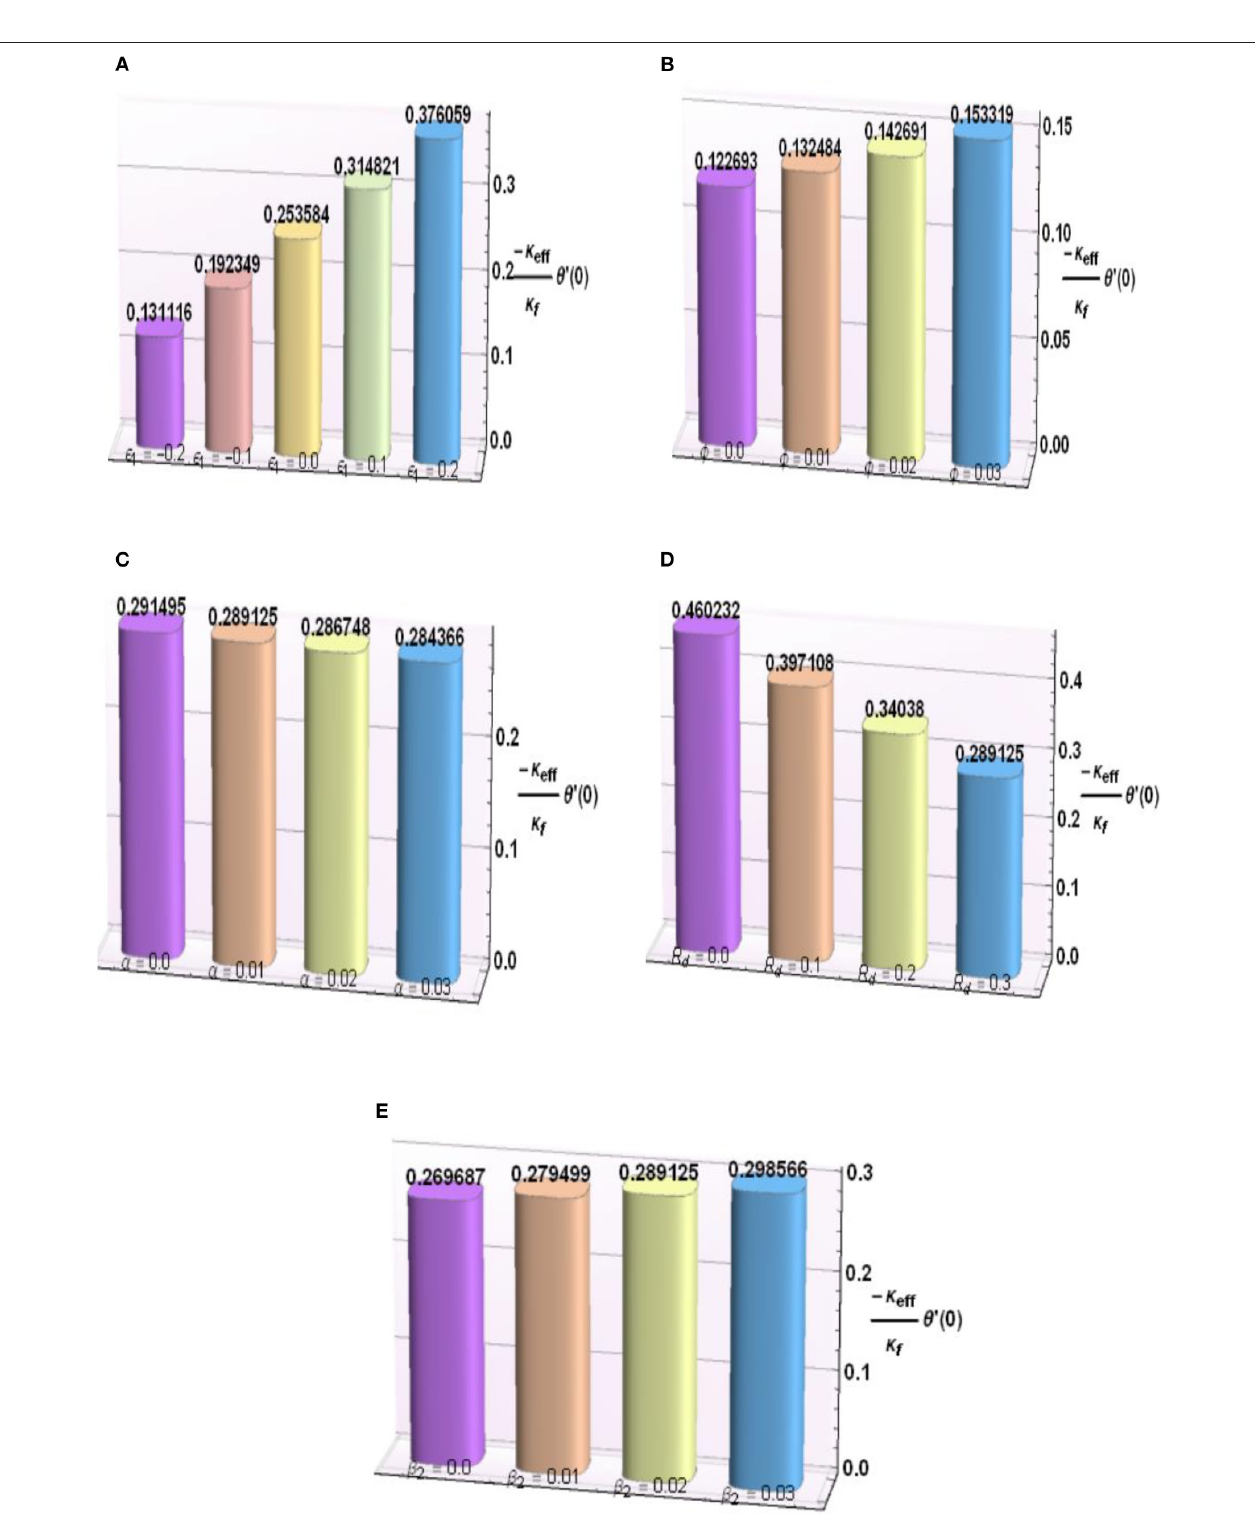
θ ′ (0) against ε 1 , φ , α , R d , and β 2 . κ f